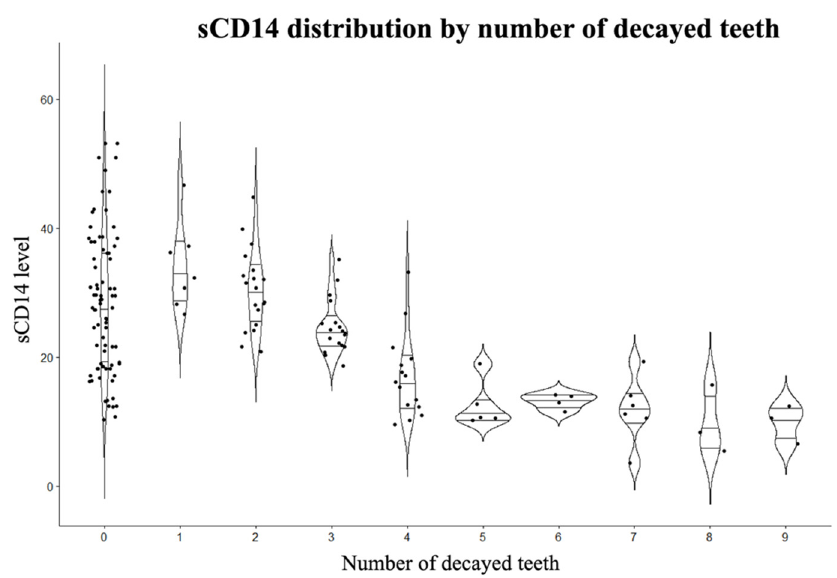
Figure 1. sCD14 distribution by number of decayed teeth violin plot showing density distribution with quartiles of sCD14 for each number of decayed teeth.